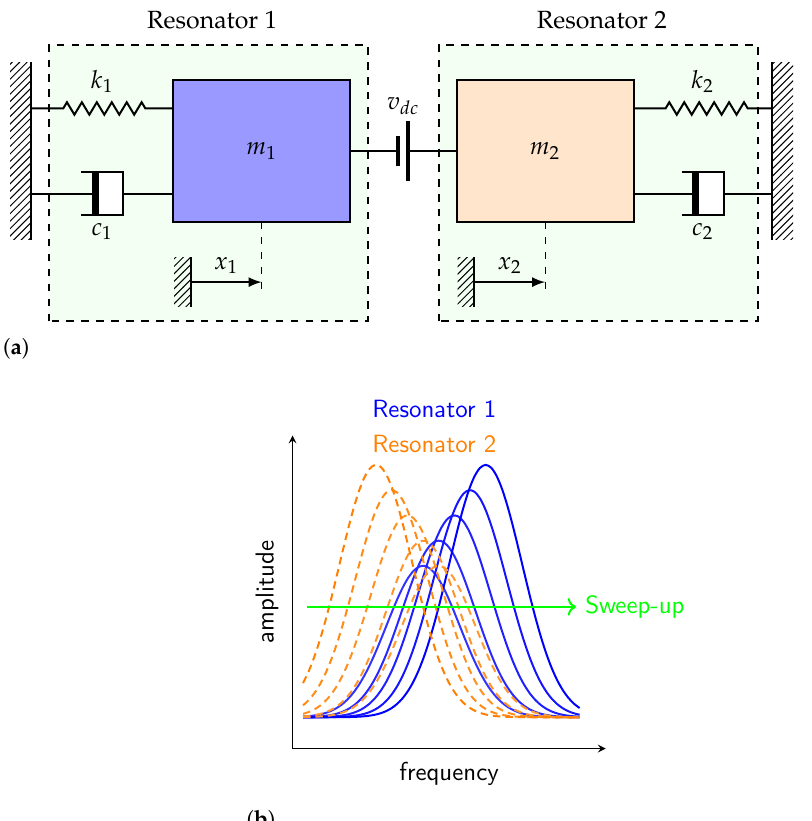
Figure 2. ( a ) A schematic showing the electrostatically coupled microbeams and ( b ) typical mode- localized based sensors frequency-response